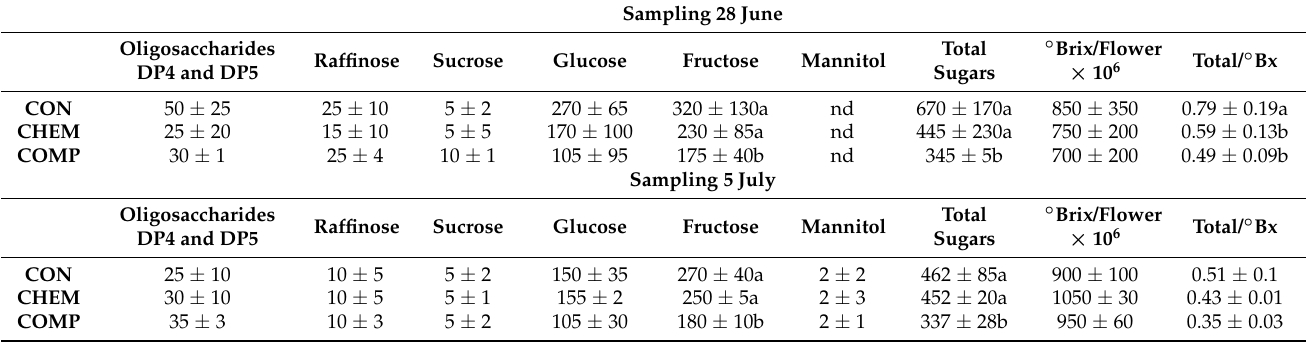
Table 4. Results of flower extracted nectar analysis. In each column, values with different letters indicate mean values significantly different according to the Tukey’s post hoc test performed on results of ANOVA with p -value < 0.05. Units are expressed as µ g/flower, and the ◦ Bx value is multiplied by 106. nd = not detectable. CON = Control; CHEM = chemical fertilizer; COMP =